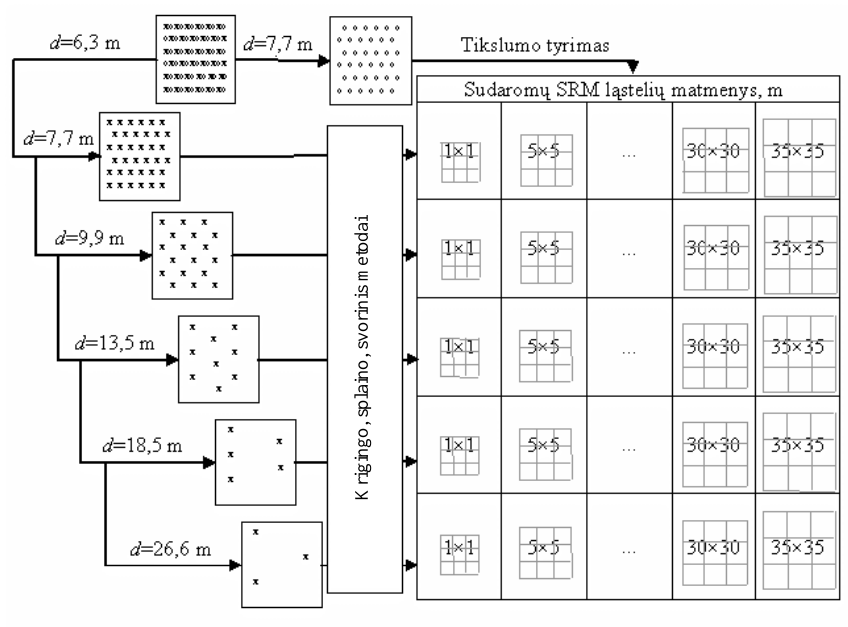
Fig 1. The research scheme of DTM accuracy dependence on the dimensions of cell and distance between points Vidutin ė kvadratin ė paklaida gauta 0,14 m, tod ė l